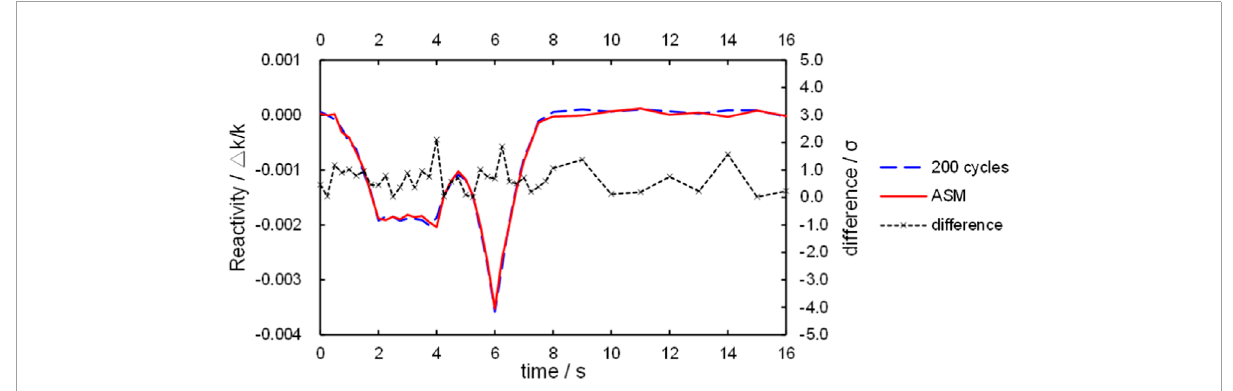
FIGURE 7 Comparison of reactivity profiles, obtained by setting 200 inactive cycles and using ASM.